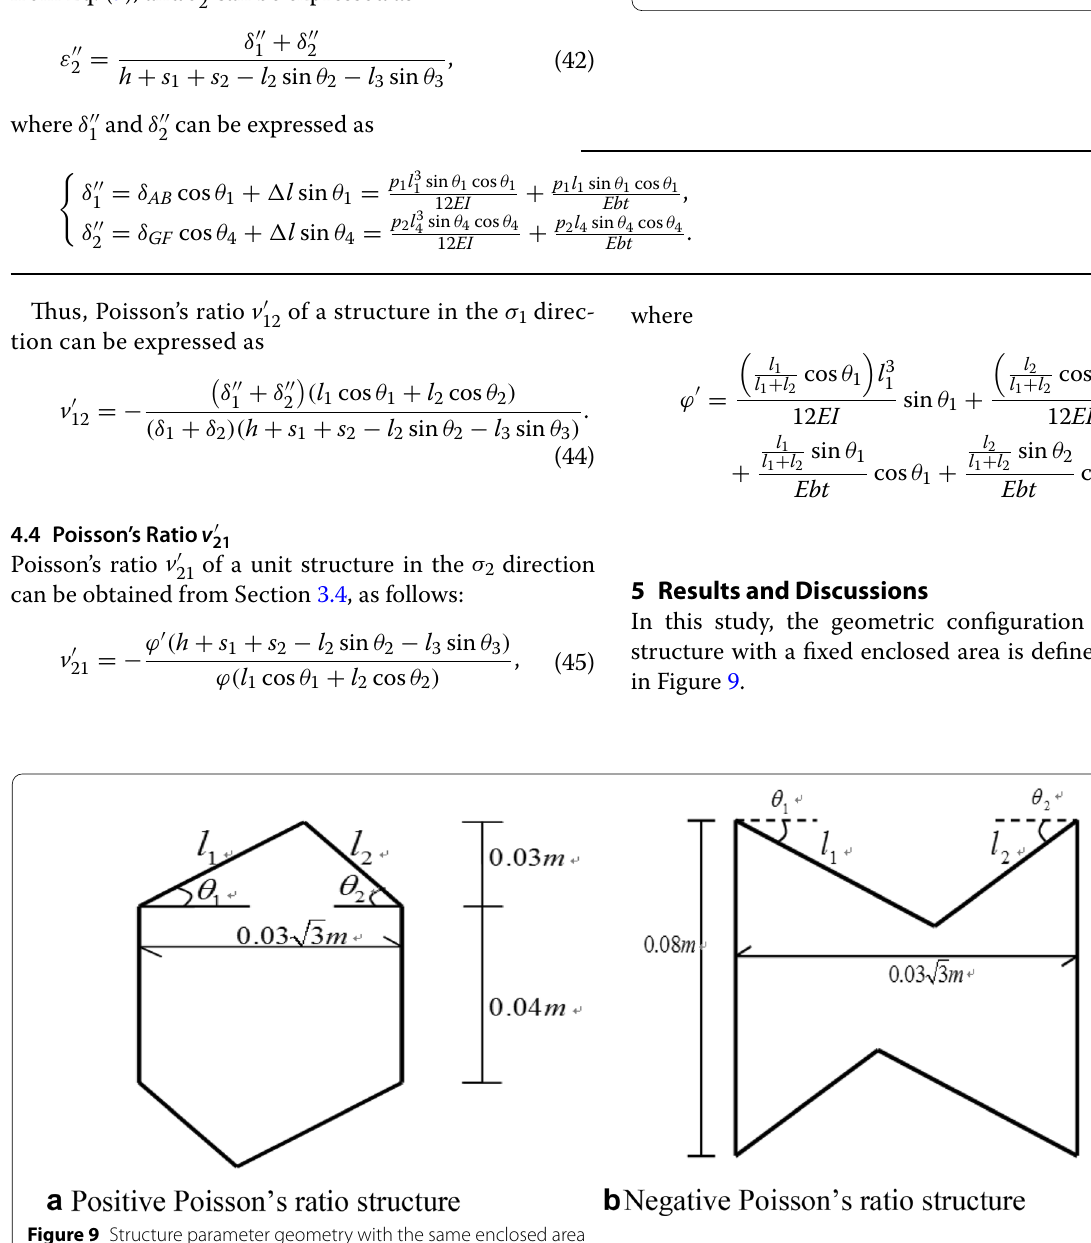
Figure 10 Elastic modulus E 1 with variation of angle θ 1 in the σ 1